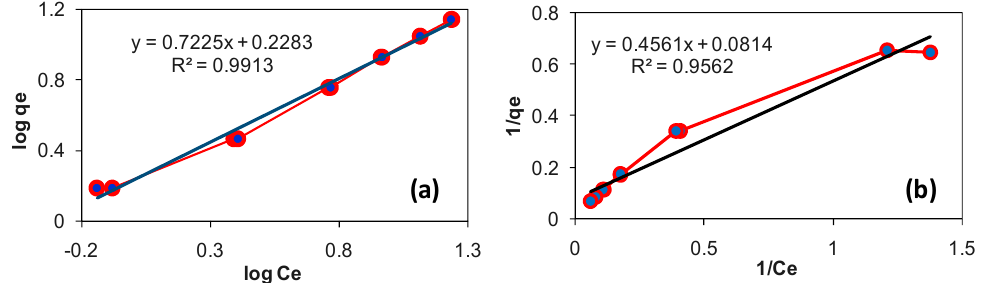
Figure 11. ( a ) Freundlich adsorption isotherm and ( b ) Langmuir adsorption isotherm for adsorption of RBV-5R on SCB.